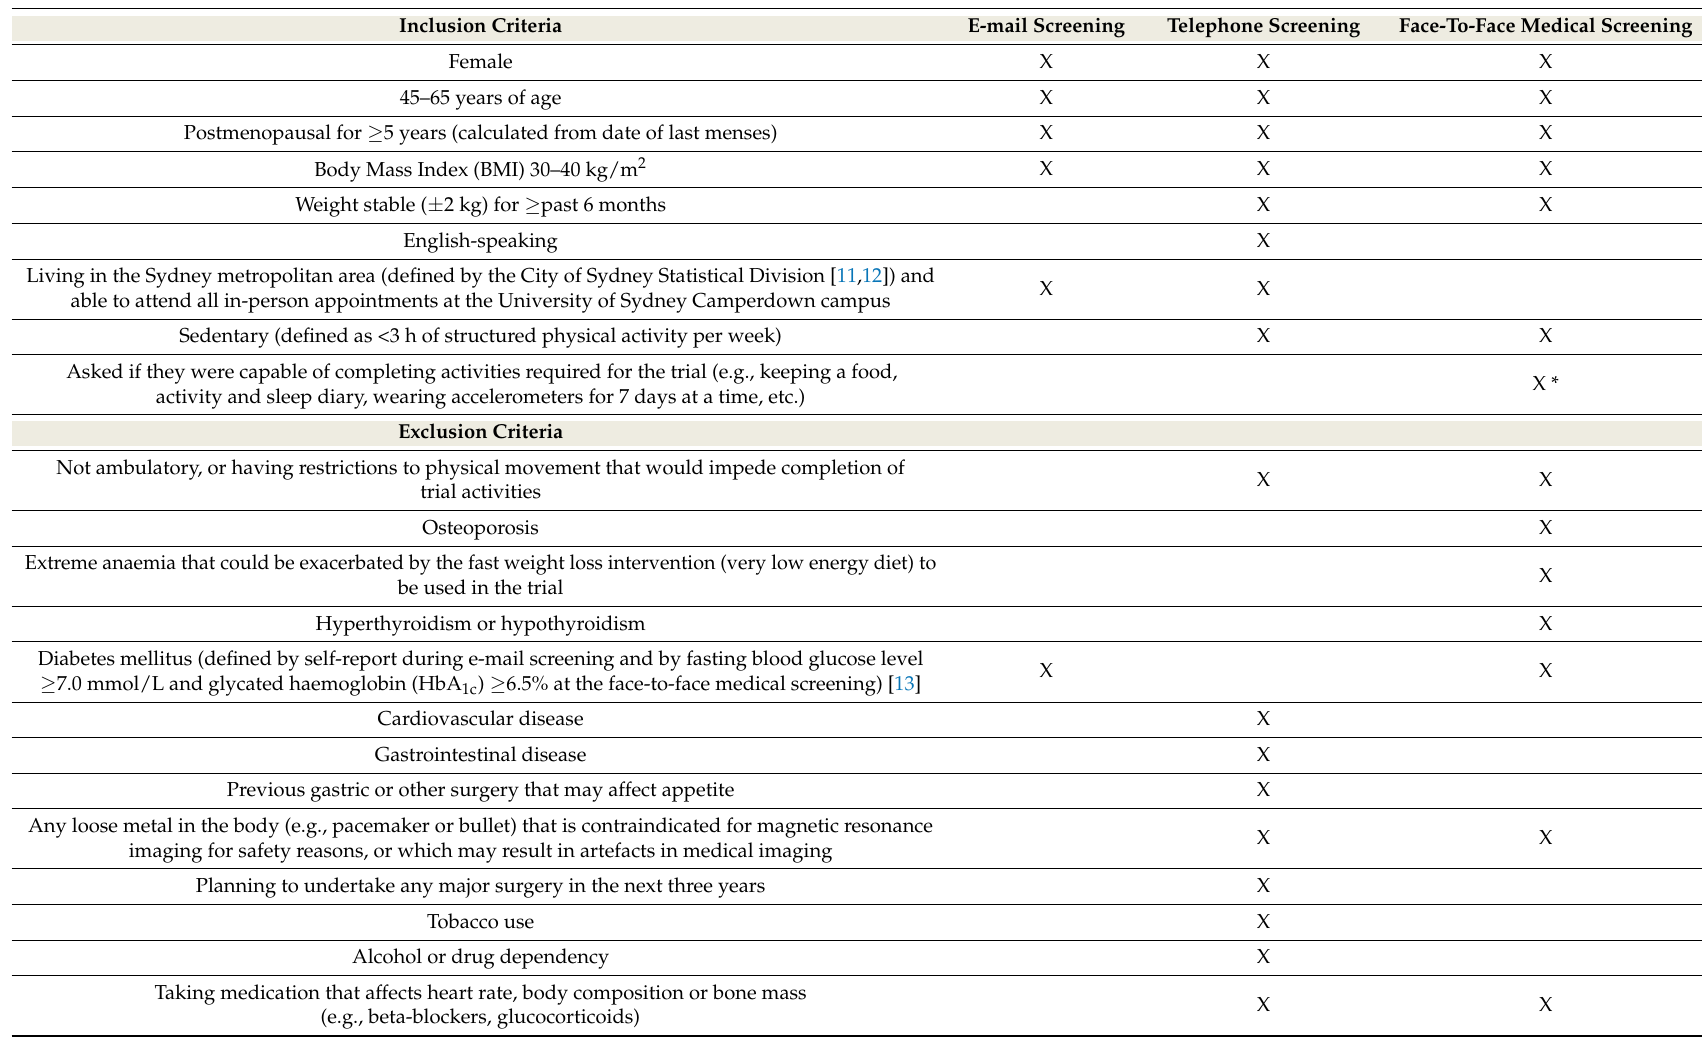
Table 1. Screening methods used to investigate inclusion and exclusion criteria for the TEMPO Diet